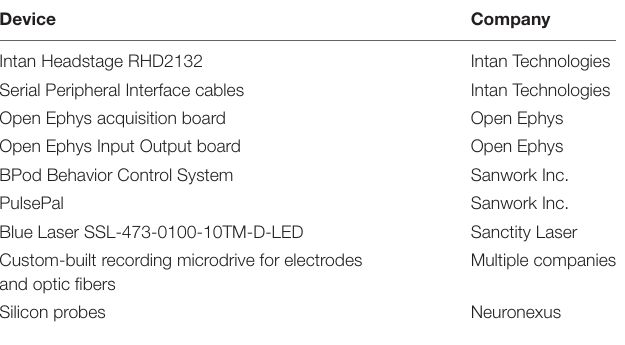
TABLE 1 | List of main components used during the